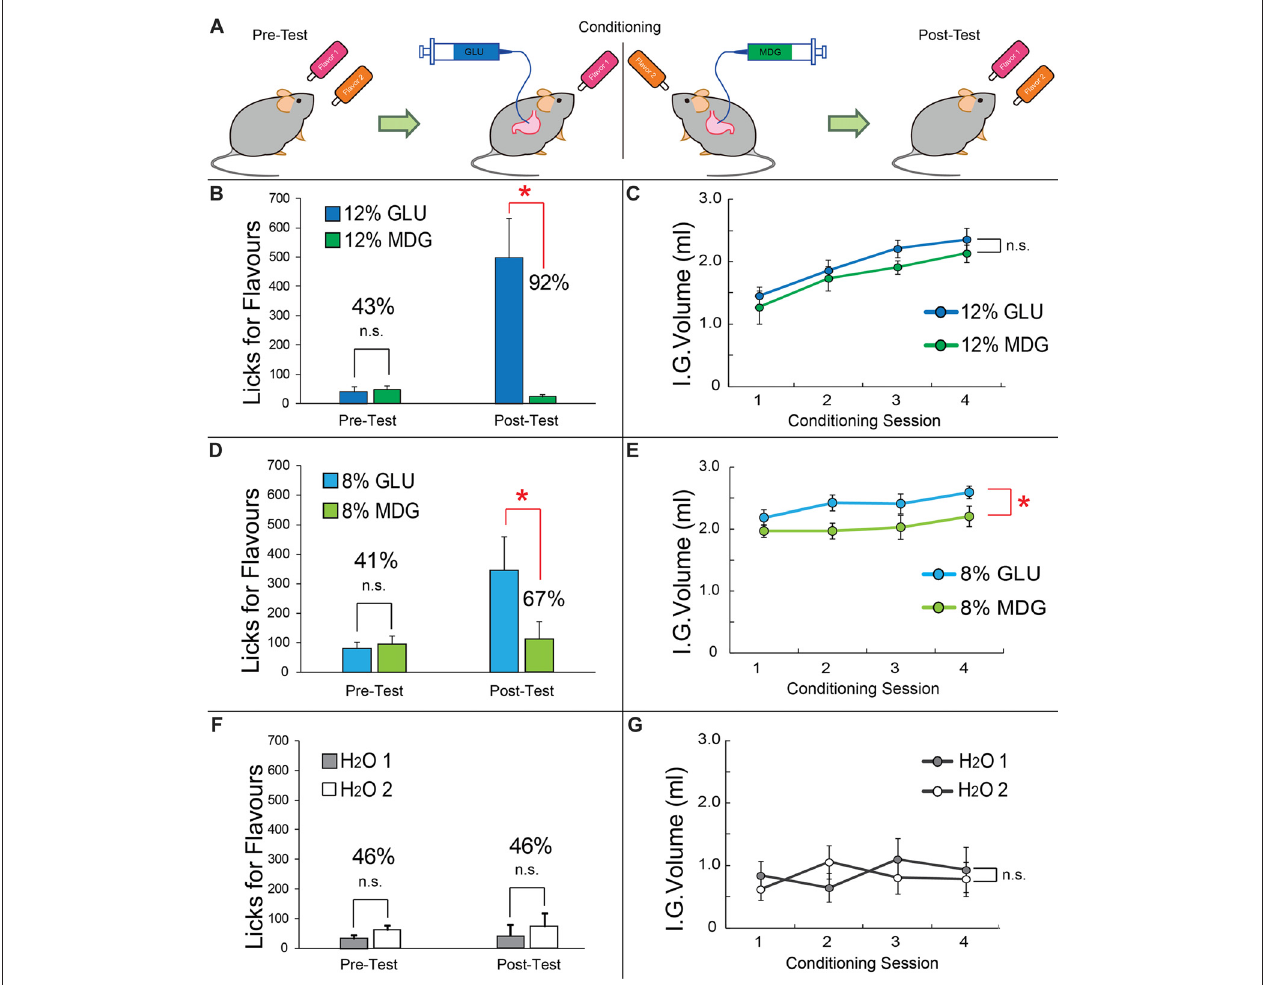
FIGURE 1 | Flavors associated with gut infusions of glucose are significantly preferred over Flavors associated with gut infusions of MDG. (A) Flavor-nutrient conditioning paradigm. Previous to the Flavor conditioning sessions, mice were tested for their preferences for the two Flavors in short-term, two-bottle 5 min preference tests in the absence of gut infusions. For condition training, in separate, alternate days, one of the two Flavors (e.g., red) is associated with intra-gastric infusions of glucose (GLU) whereas the second Flavor (e.g., orange) is associated with intra-gastric infusions of the non-metabolizable glucose analog MDG. GLU and MDG solutions were prepared at 12% (because this concentration has been previously shown to induce similar Flavor preferences conditioned by both GLU and MDG (against water infusions) in C57BL6 mice (Zukerman et al., 2013)), 8% and 0%. These “conditioning sessions” lasted for 1 h and were performed for eight consecutive days under food (16 h) deprivation, alternating daily the Flavor-sugar association. Therefore, each Flavor-sugar pair was associated with four conditioning sessions. Importantly, for each animal, Flavors were arbitrarily paired with either GLU or MDG in a balanced design, thereby preventing Flavor identity to influence preference formation. Formation of Flavor preferences were assessed with post-conditioning short-term, two-bottle 5 min preference tests, also in the absence of gut infusions. (B) Short-term two-bottle preference tests performed before (left) conditioning sessions reveal no differences between number of licks produced for the 12% GLU-associated vs. 12% MDG-associated Flavor ( post hoc paired t -test, N = 6, p = 0.36), resulting in a preference of 43% for the 12% GLU-associated Flavor. However, similar tests performed after conditioning sessions (right) show a striking increase in the number of licks for the 12% GLU-associated Flavor ( ∗ p = 0.01), resulting in a preference of 92% for the 12% GLU-associated Flavor. (C) Number of gut infusions produced throughout the conditioning sessions revealed no major differences between infused volumes of each sugar (two-way ANOVA conditioning session × sugar, p = 0.85). (D) Short-term two-bottle preference tests performed before (left) conditioning sessions reveal no differences between number of licks produced for the 8% GLU-associated vs. 8% MDG-associated flavor ( post hoc paired t -test, N = 6, p = 0.2), resulting in preferences of 41% for the 8% GLU-associated flavor. However, after conditioning sessions (right), a significant increase in the number of licks for the 8% GLU-associated flavor ( ∗ p = 0.048) was observed, resulting in a preference of 67% for the 8% GLU-associated flavor. (E) Number of gut infusions produced throughout the conditioning sessions revealed 8% GLU was infused at higher volumes (sugar effect, F ( 1,5 ) = 6.7, ∗ p = 0.049). (F) A control group was exposed to the exact same protocol as above (panels B,C ) except that this time licks for either Flavor resulted in gut infusions of water throughout conditioning sessions. Short-term two-bottle preference tests performed before (left) conditioning sessions reveal no differences between number of licks produced for the GLU-associated vs. MDG-associated Flavor ( post hoc paired t-test , N = 6, p = 0.54), resulting in a preference of 46% for the GLU-associated Flavor. Similar tests performed after conditioning sessions (right) failed to show any increases in the number of licks for the GLU-associated Flavor ( p = 0.36), resulting in a preference of 46% for the GLU-associated Flavor. (G) Number of gut infusions produced throughout the conditioning sessions revealed no differences between infused water volumes associated with each Flavor (two-way ANOVA conditioning session × sugar, p = 0.06). GLU, glucose; MDG, α -methyl-D-glucopyranoside; IG, Intra-Gastric infusion; ns, non-statistically significant. Data depicted as mean ± SEM, across animals in all figures.